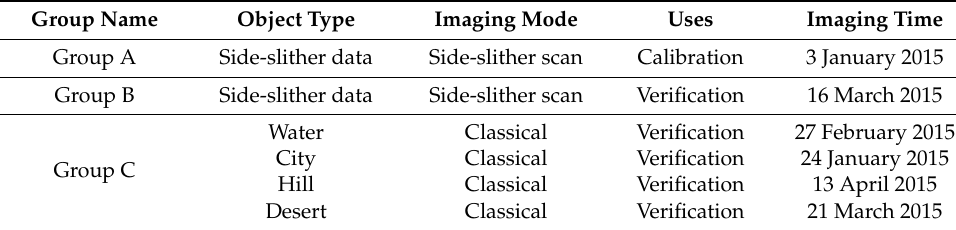
Table 1. Details of the experimental